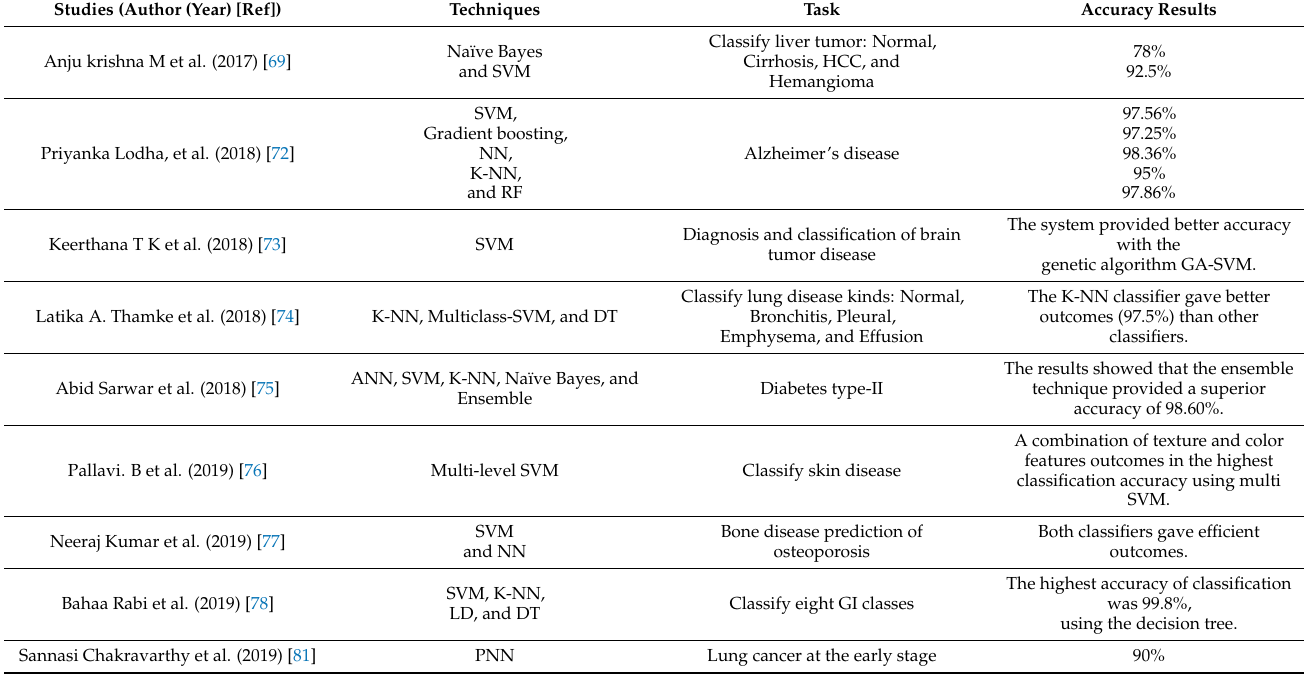
Table 4. Distribution of studies for the most common ML classification